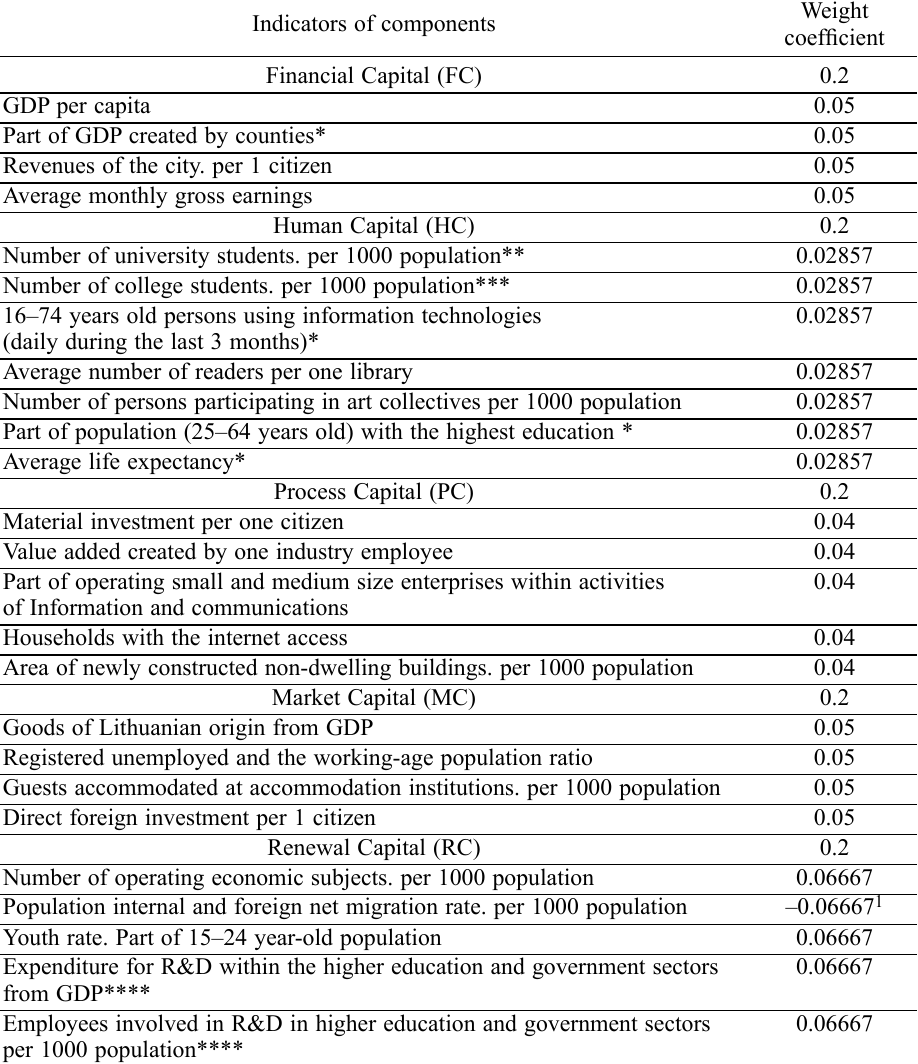
Table 1. City’s intellectual capital index components Indicators of